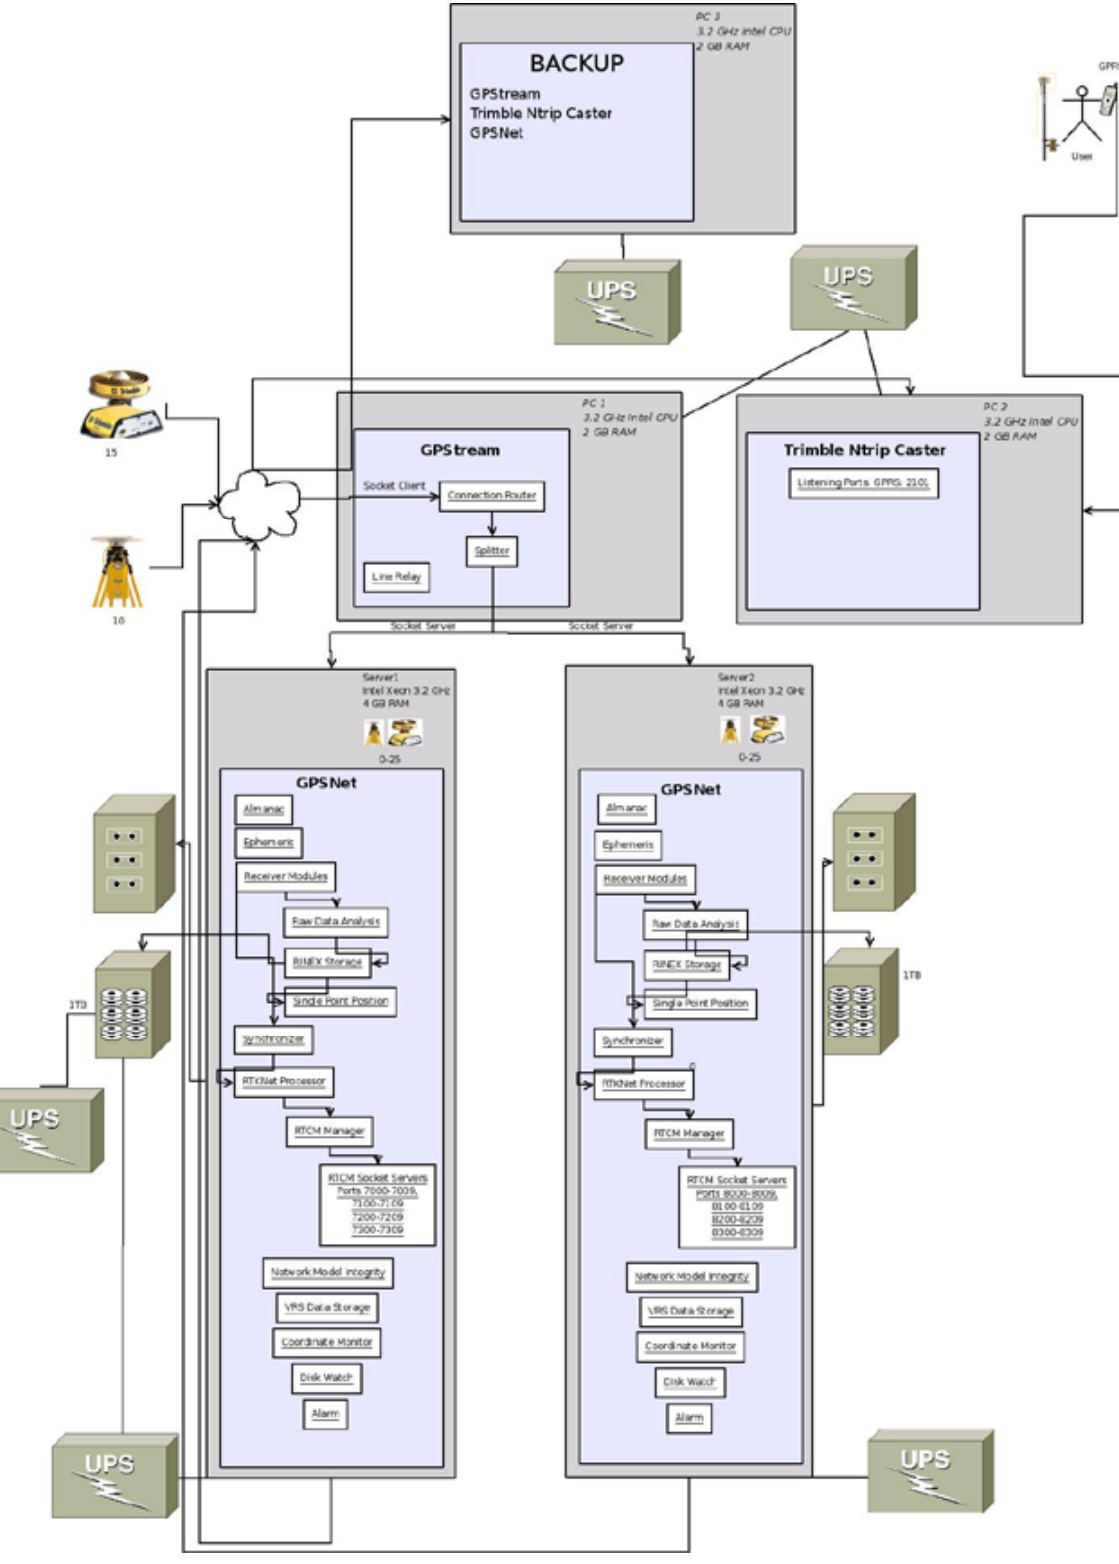
Fig. 5. Principal scheme of hardware and data